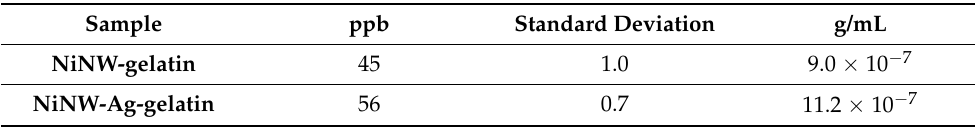
Table 1. Results of ICP analyses for gelatin-coated nanowire samples.